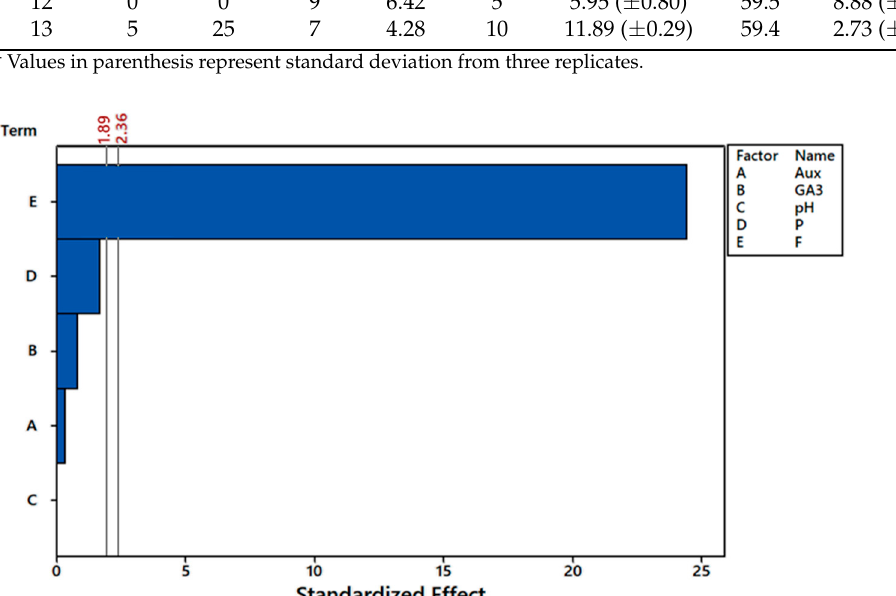
Figure 3. Pareto chart of first order effects for auxin (A), gibberellin (B), pH (C), phosphorus initial concentration (D), and fluoride initial concentration (E) on fluoride removal per dry mass of plant, considering α = 10% (1.895) and α = 5% (2.365). The bars behind the thresholds of α values represent factors that were not significant to the response variable. For gibberelin, fluoride removals were increased by an application of 25 µM GA 3 as compared with the control (0 µM GA 3 ), even though such an occurrence was not statisti- cally significant (10%). Interestingly, treatment of E. crassipes with 50 µM GA 3 promoted a similar increase in fluoride removals in relation to the 25 µM GA 3 , indicating that fluoride